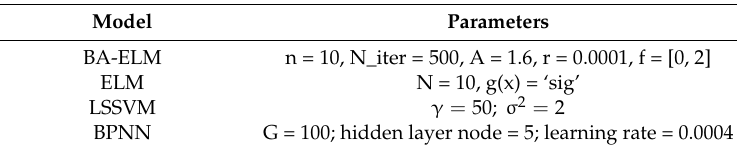
Table 5. Parameters of models.